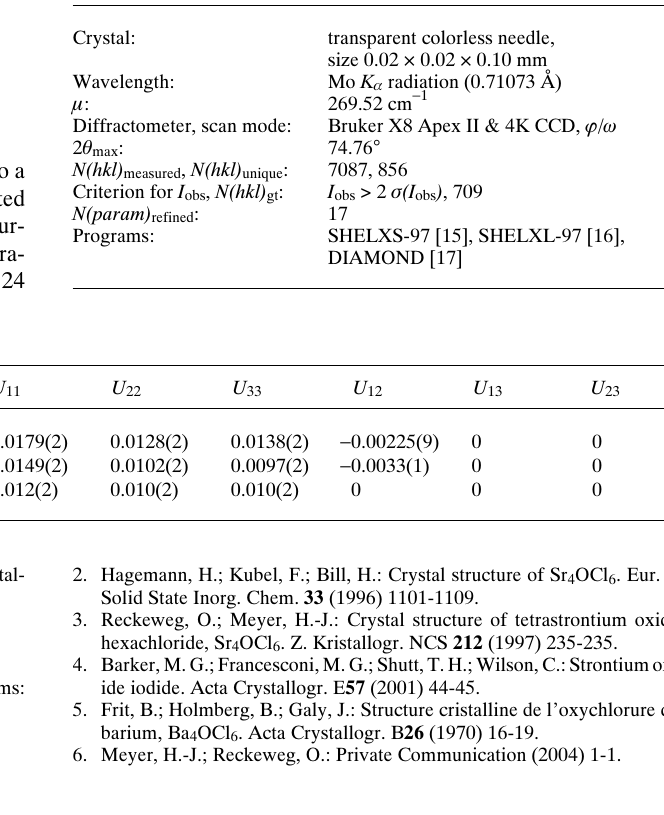
Table 1. Data collection and